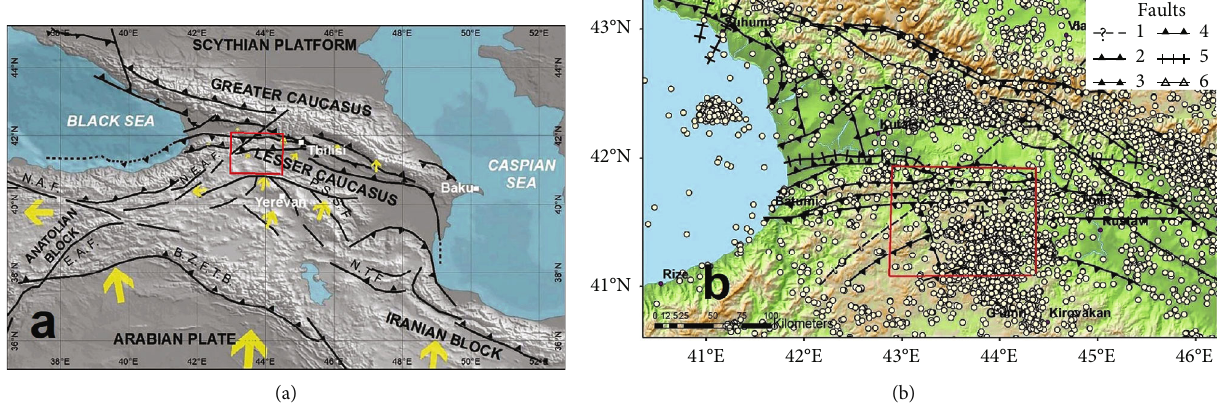
Figure 1: (a) Tectonic setting of the Caucasus region. N.A.F.: North Anatolian Fault, E.A.F.: East Anatolian Fault, N.E.A.F.: Northeast Anatolian Fault, B.Z.F.T.B.: Bitlis-Zagros Fold and Thrust Belt, N.T.F.: North Tebriz Fault, and P.S.S.F.: Pambak-Sevan-Sunik Fault. The fastest velocity vector is the northward movement of the Arabian Plate at 25 mm/yr [31]. (b) Epicenters of earthquakes ( M L ≥ 2 : 0 ) occurred in Georgia from 2003 to 2019 (grey circles), the active faults are also shown, 1 refers to the strike-slip, 2 refers to the reverse, 3 refers to the left reverse, 4 refers to the right reverse, 5 refers to the normal fault, and 6 refers to the nappe. The Javakheti plateau is marked with a red